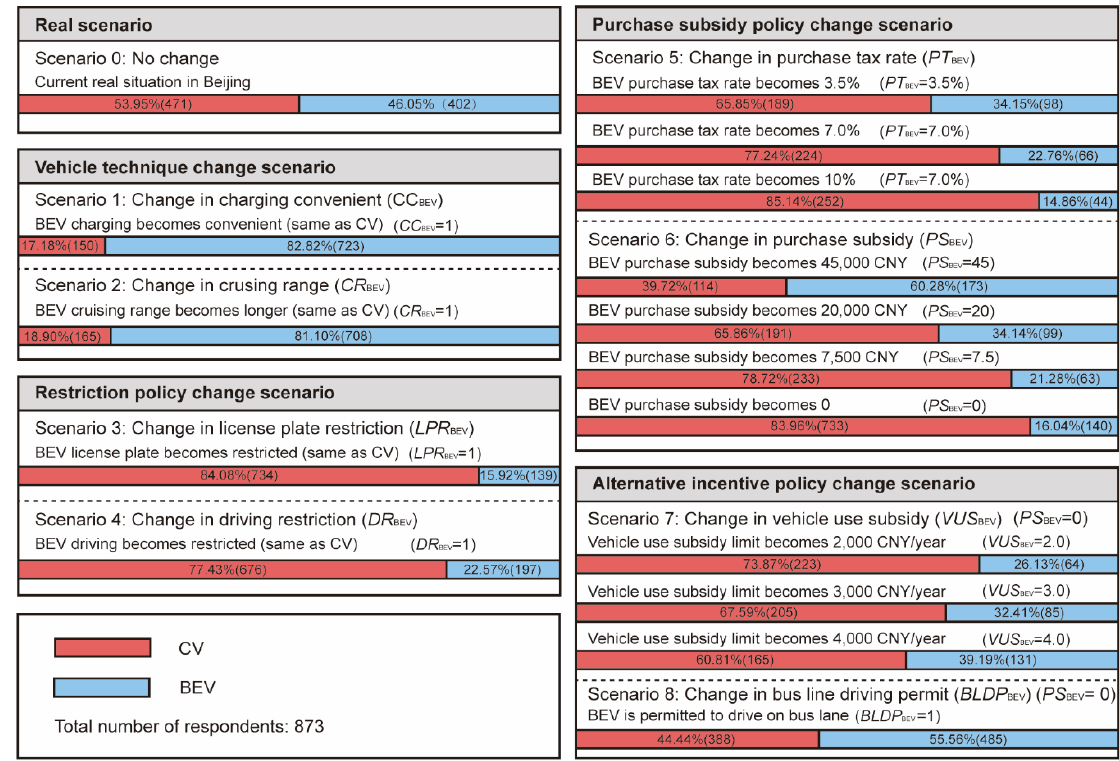
Figure 5. Choice result statistics for each scenario in the survey.